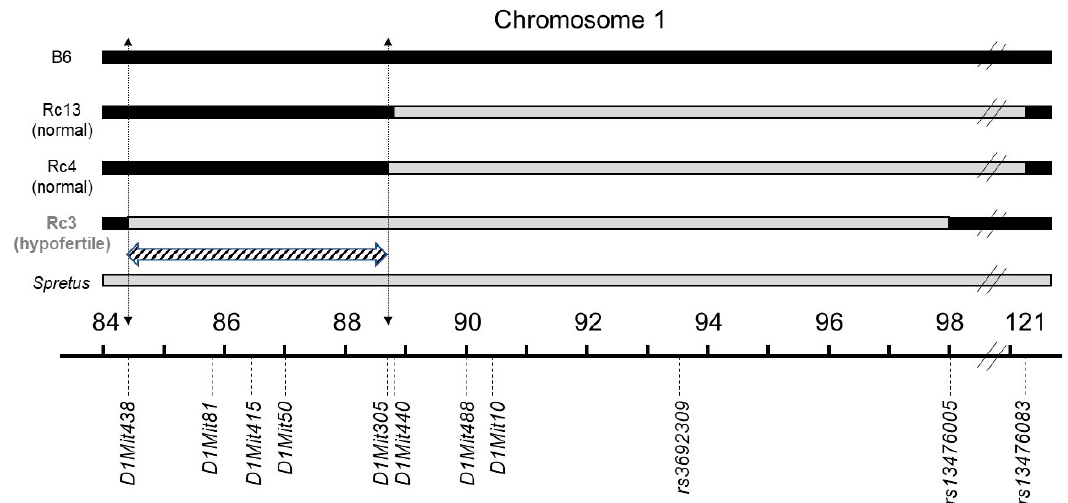
Figure 1. Genotypes of the different recombinant strains (Rc) and the parental strains ( spretus and B6). Recombinant strains (Rc) were generated at the Institut Pasteur (Paris) from the 66HMMU1 strain by recombination events inside the MMU1 spretus segment. Black regions correspond to B6 background, grey regions to spretus fragments and the minimal spretus region responsible for the phenotype of interest is highlighted in hatched on chromosome 1. Marker positions are given in mega base pairs (Mb). Genome version GRCm38.p6.